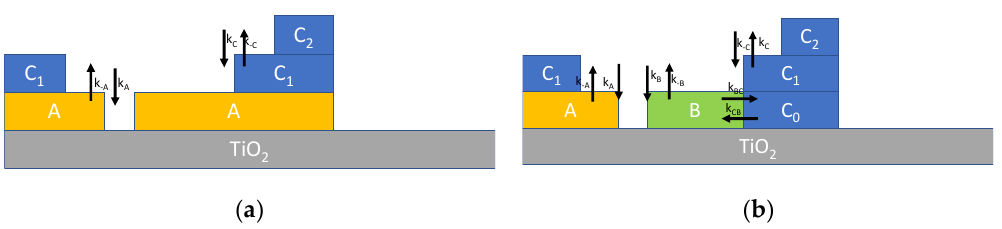
Figure 2. Schematic representation of multilayer adsorption of water on TiO 2 nanoparticles. ( a ) Multilayer adsorption according to BET theory described by Equation (3). ( b ) Multilayer adsorption route according to [18] described by Equation (4).